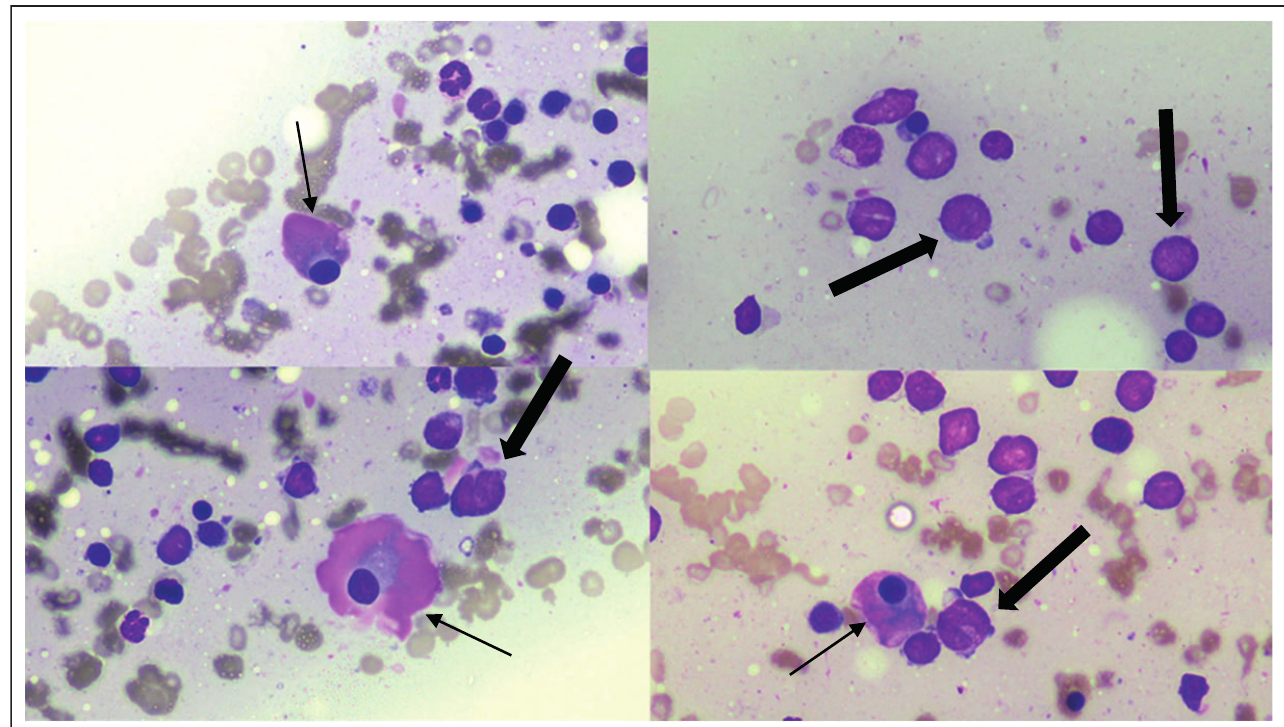
FIGURE 1: Bone marrow aspirate showing blasts (thick arrows) and flame cells (thin arrows). BOX 1: International Myeloma Working Group diagnostic criteria for multiple myeloma and smouldering multiple myeloma. Multiple Myeloma Clonal bone marrow plasma cells > 10 % or plasmacytoma PLUS 1 or more of the following myeloma defining